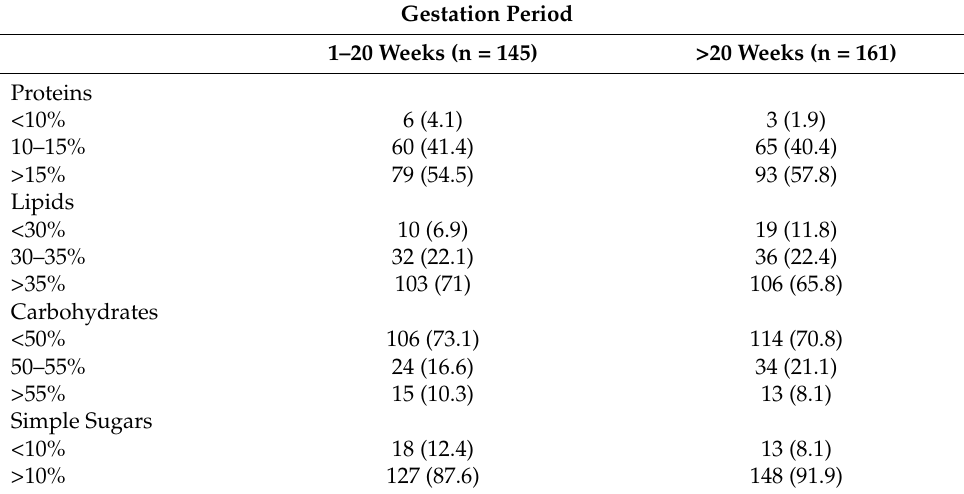
Table 4. Contribution of macronutrients and sugars to the TCV (caloric profile) (frequencies and percentages).